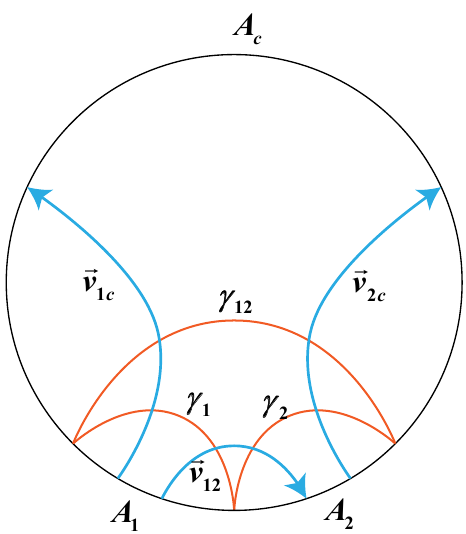
Figure 1 . A locking bit thread configuration involving three elementary regions A 1 , A 2 , and A c . It is described by a ν v multiflow V = { ~v ij } , in which each component flow ~v ij is represented by a blue line. The red lines denote the RT surfaces associated with the involving boundary